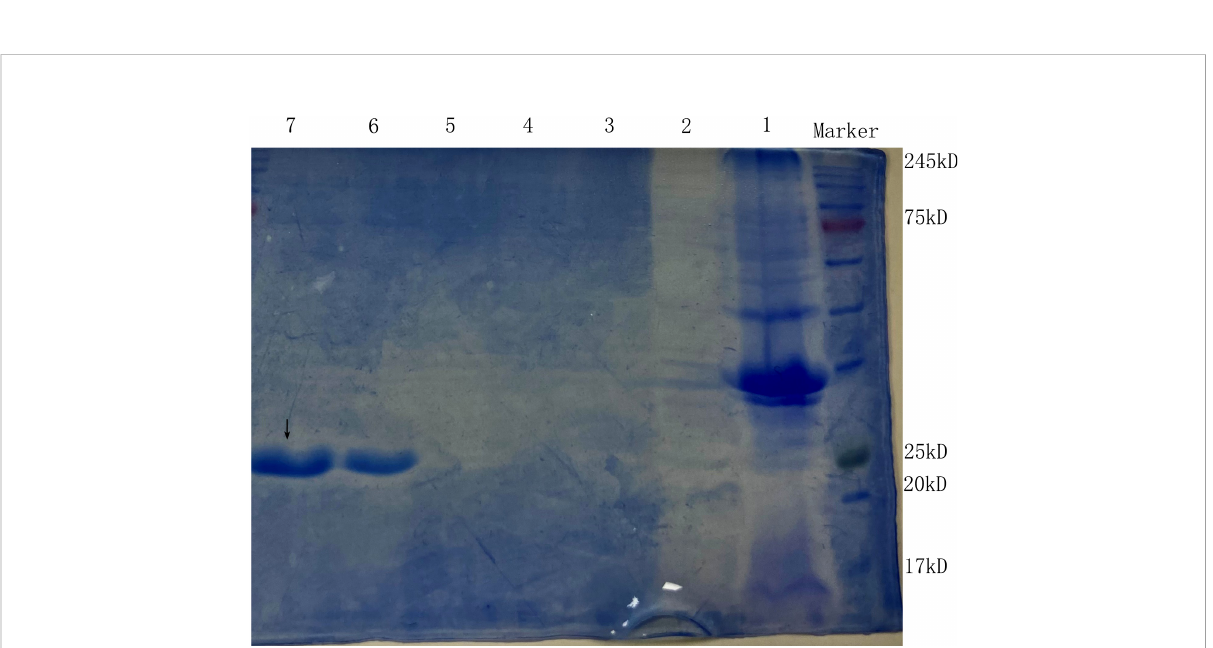
FIGURE 2 The SDS-PAGE of the anti-restriction protein ArdA. Lanes 1 and 2 are the precipitate and supernatant of E. coli BL21 (pET20b-ArdA) obtained by ultrasonic fragmentation without puri fi cation, respectively. Lanes 3, 4, 5, 6 and 7 are the target protein ArdA with His tag obtained after puri fi cation with 100 mM-500 mM imidazole-eluting nickel columns, located at the positions indicated by